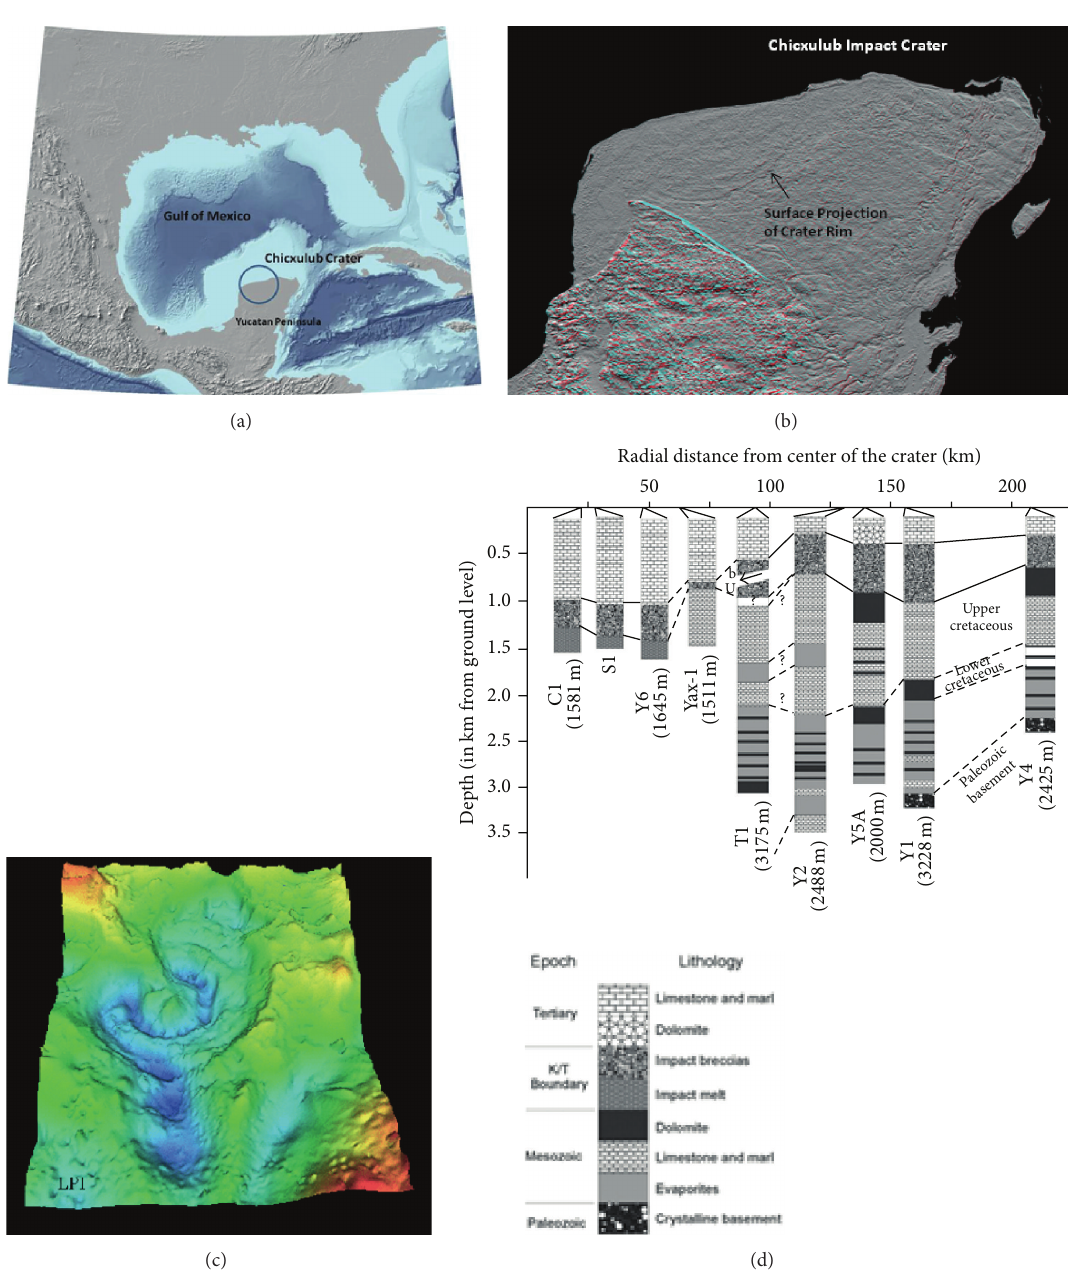
Figure 7: Chicxulub impact crater. (a) Gulf of Mexico and location of Chicxulub crater in the Yucatan platform. (b) Satellite interferometric radar image of Yucatan peninsula (credits: JPL-Caltech NASA), showing surface features associated with the buried crater structure. (c) Bouguer gravity anomaly of the Chicxulub crater (Sharpton et al. [40]). (d) Schematic lithological columns and lateral correlation for deep boreholes in the Chicxulub crater area, plotted as a function of relative distance to crater center (Urrutia-Fucugauchi et al. [27,